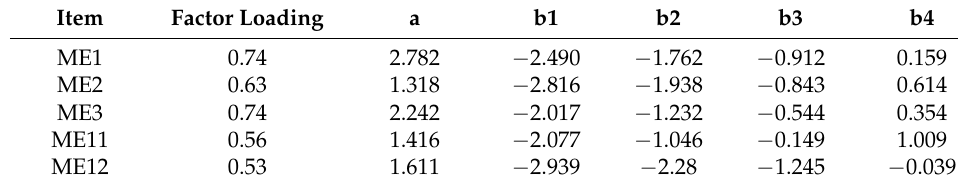
Table A4. Estimation of items parameters of the Mindless Eating subscale.